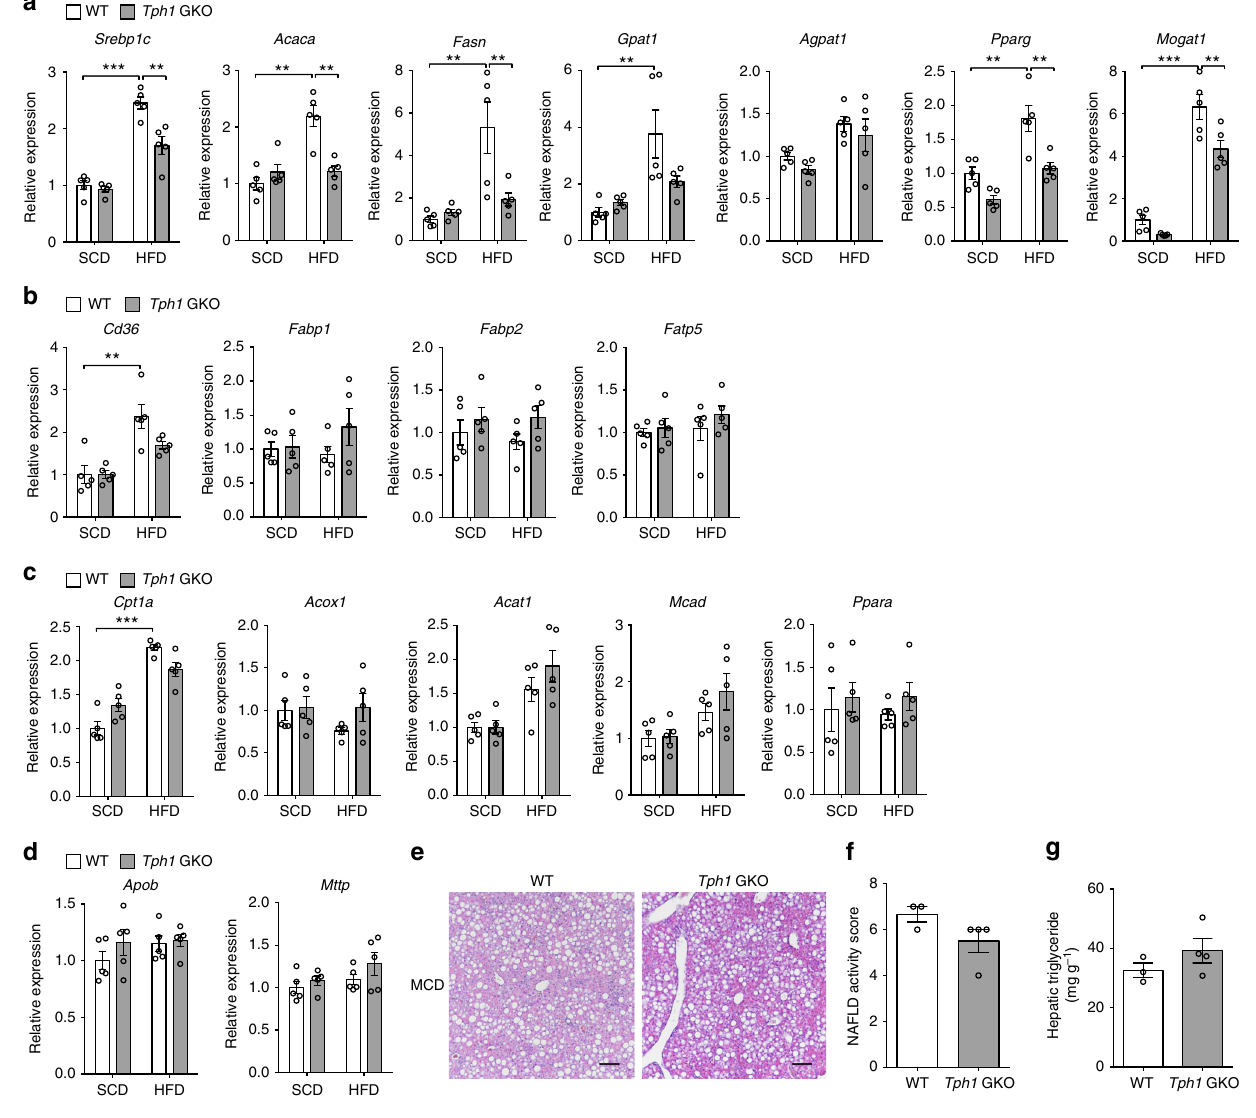
Fig. 3 Gut-derived 5-HT regulates lipogenic pathways in the liver. a – d The 12-week-old WT and Tph1 GKO mice were fed SCD or HFD for 8 weeks. Relative mRNA expression of genes involved in lipogenesis ( a ), FA uptake ( b ), FA oxidation ( c ), and VLDL secretion ( d ) as assessed by qRT-PCR in liver; n = 5 per group. e – g The 8-week-old WT and Tph1 GKO mice were fed MCD diet for 6 weeks. e Representative liver histology by H&E staining. Scale bars, 100 μ m. f NAS; n = 3 – 4 per group. g Hepatic triglyceride levels; n = 3 – 4 per group. Data are expressed as the means ± SEM. ** P < 0.01, *** P < 0.001, Student ’ s t -test ( f , g ) or one-way ANOVA with post hoc Tukey ’ s test ( a – d